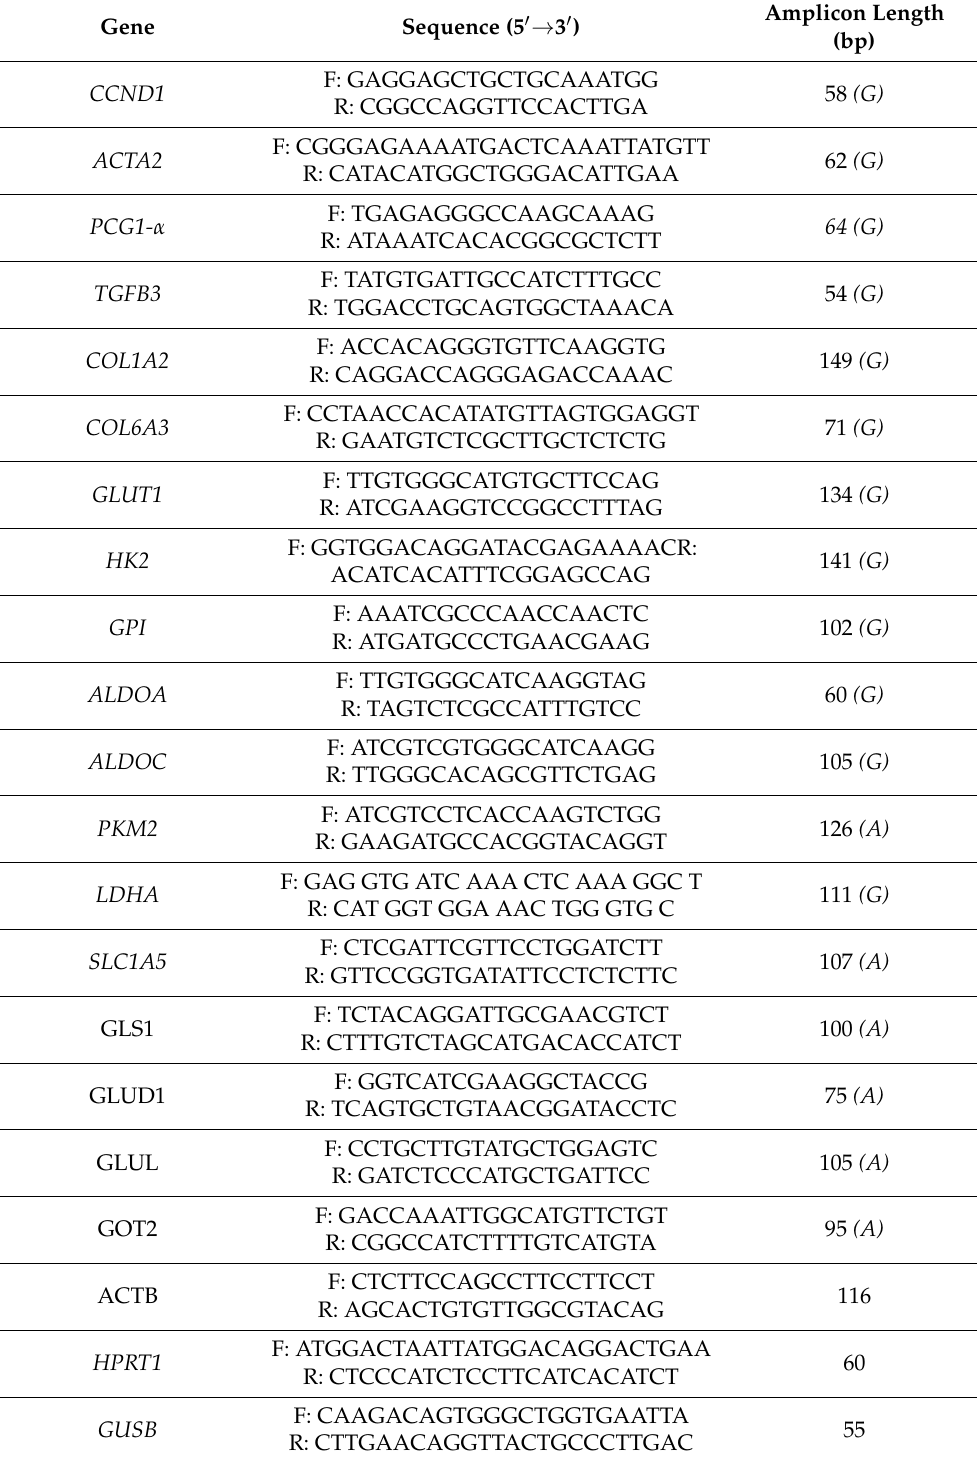
Table 1. List of primers used for RT-qPCR; primer sequences and amplicon lengths, with GUSB (G) , HPRT1 (H) , or ACTB (A) as reference genes, are